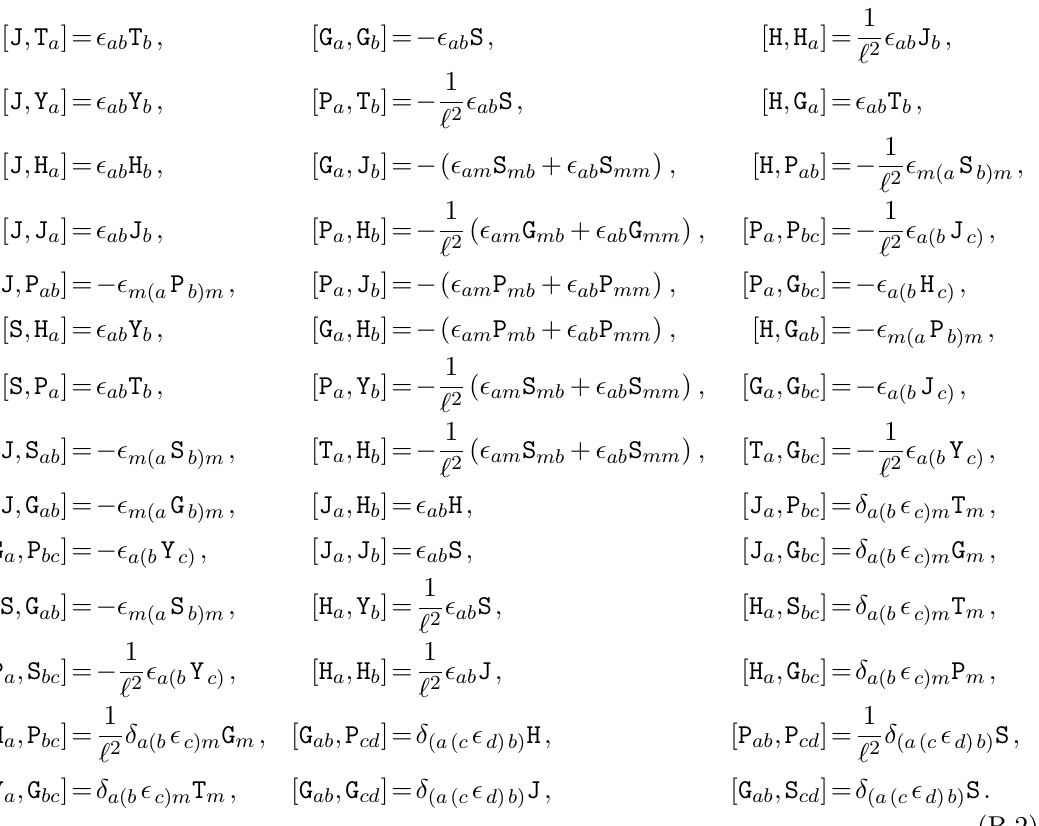
Table 5 . Inequivalent commutation relations of the spin-3 extensions of the AdS Carroll